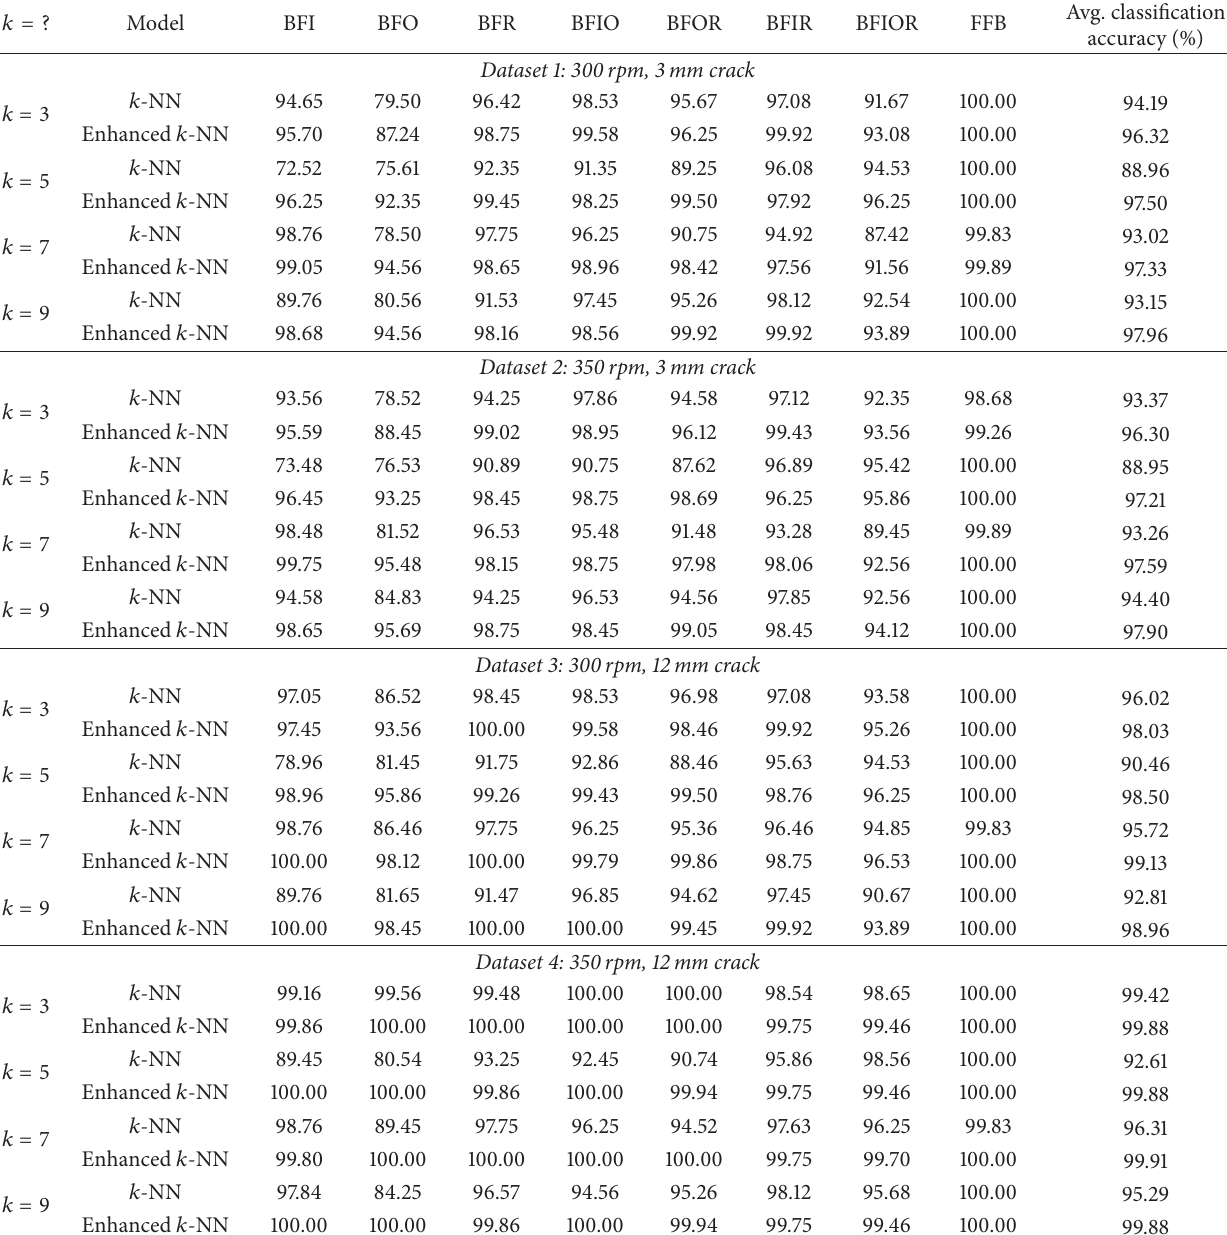
Table 4: Diagnostic performance of the two classifiers for different fault types and